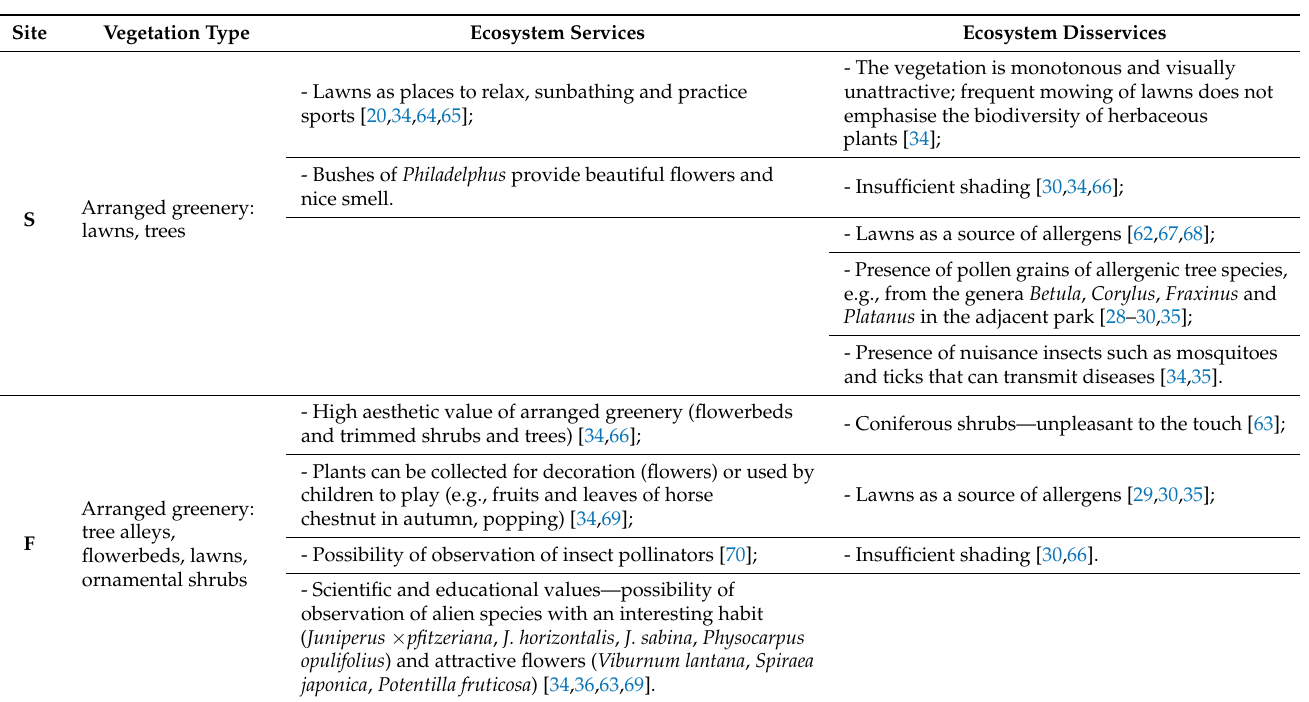
Table 3. Main ecosystem services and disservices of the vegetation in the study sites (S—open swimming pools, F—multi- media fountain, R—reservoir, G—gravel pit